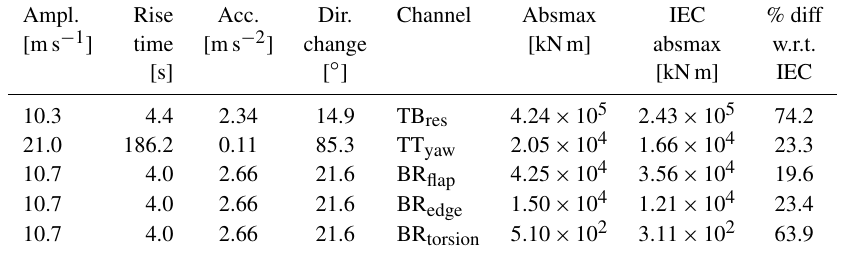
Figure 4. (a) Yaw error as a function of time for start moving average 1 (blue) and stop moving average 2 (red). The dashed blue line shows the start threshold, and the dashed red line shows the stop threshold. (b) Yaw-bearing angle as a function of time. Table 2. Absolute maxima of a selection of load channels with yaw control for gusts starting at 10ms − 1 . The IEC absmax (absolute maximum responses) column refers to the IEC DLC1.4 gust case with a rise time of 10s, amplitude of 15ms − 1 , and a directional change of 72 ◦ . Ampl. Rise